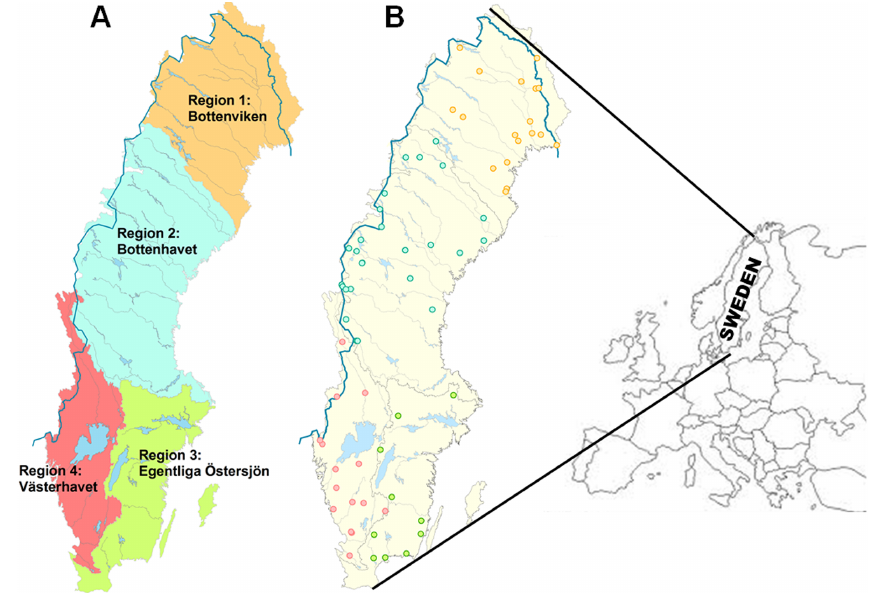
Figure 1. Maps showing (a) the four climate regions in Sweden and (b) the locations of the 69 gauges with long-term records from unregu- lated